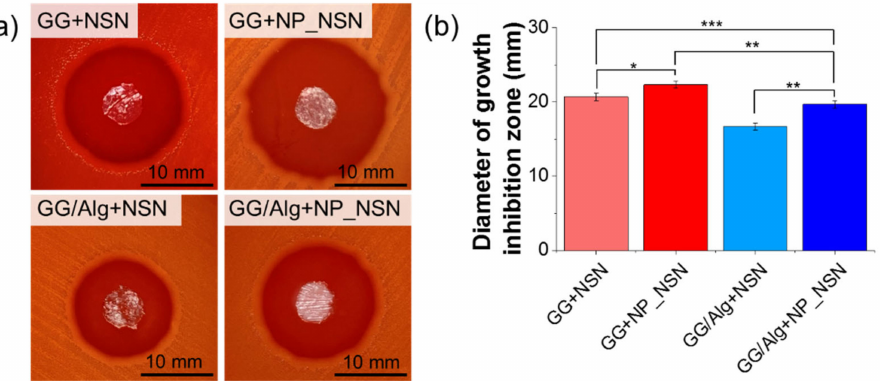
Figure 5. Antibacterial efficacy of GG and GG/Alg hydrogels containing NSN or NP + NSN: pictures of S. pyogenes growth inhibition zones ( a ) and diameters of S. pyogenes growth inhibition zones ( b ). Statistically significant differences at * p < 0.05, ** p < 0.01 and *** p <